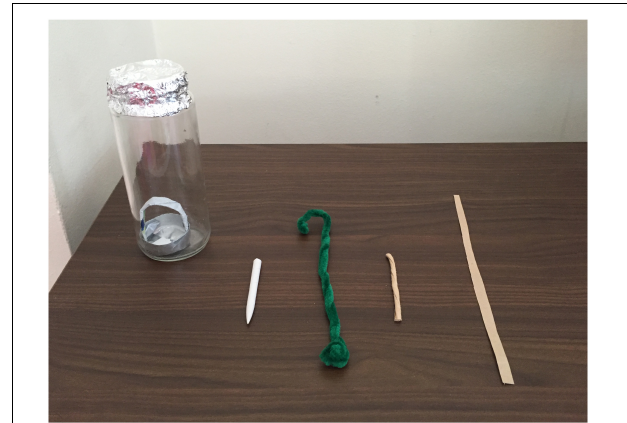
FIGURE 1 | Task and tools used in the present experiment. From left to right: Puncturing tool, hook tool, short tool, and long